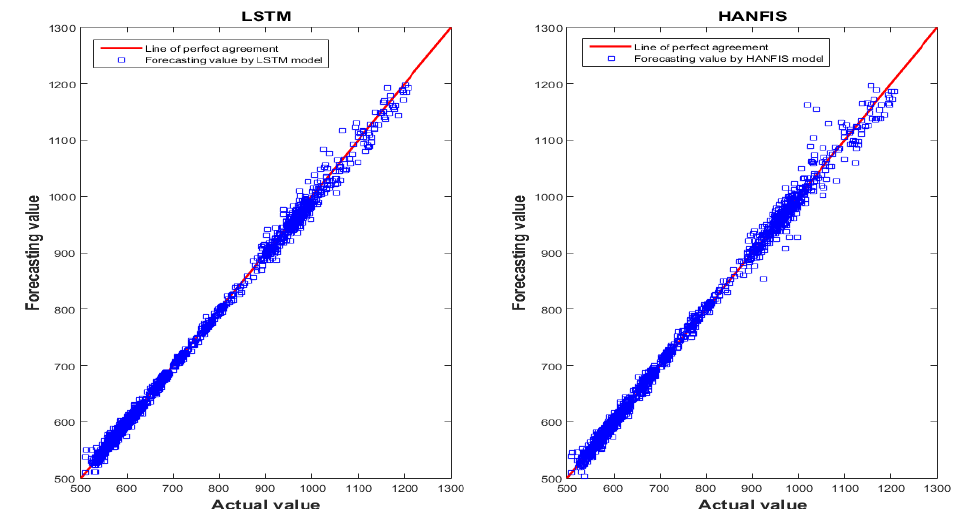
Fig. 17. The scatter plot of actual values and forecasts using HANFIS and LSTM